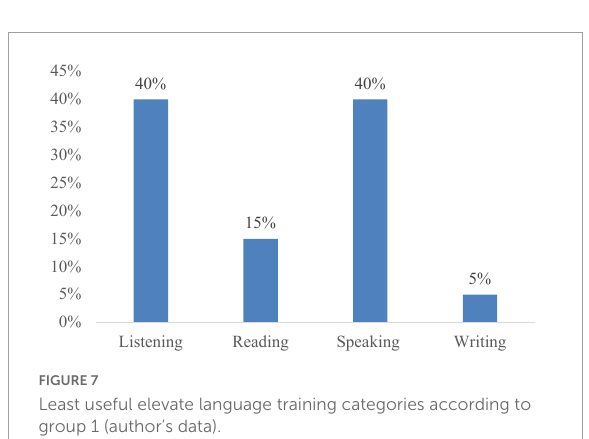
FIGURE7 Least useful elevate language training categories according to group 1 (author’s